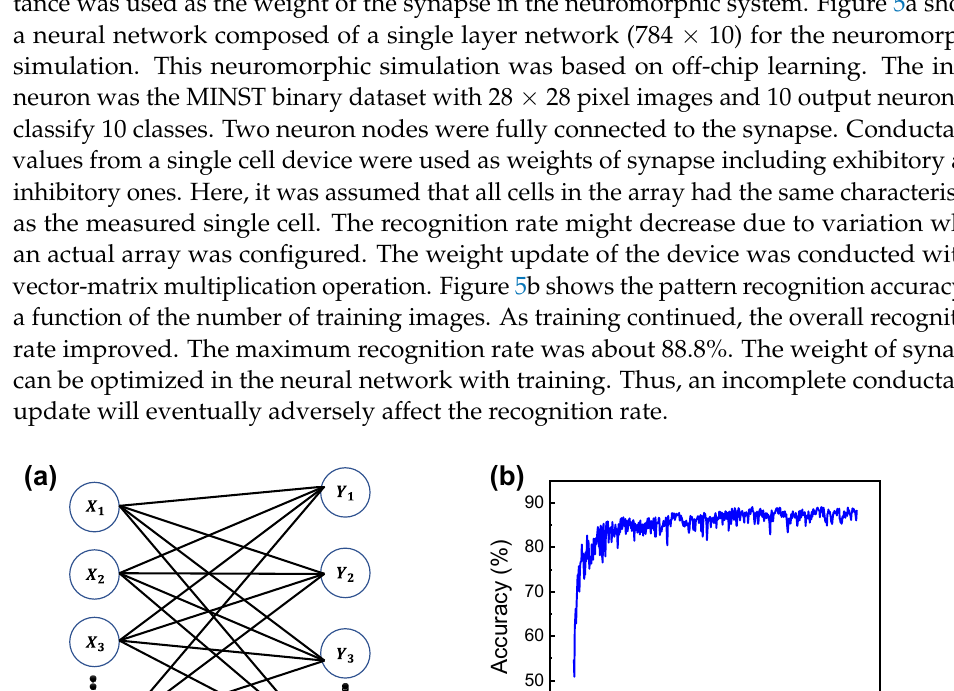
Figure 4. ( a ) Set and reset transient characteristics including set pulse, reset pulse, and read pulses; ( b ) Potentiation and depression curve as a synaptic device.